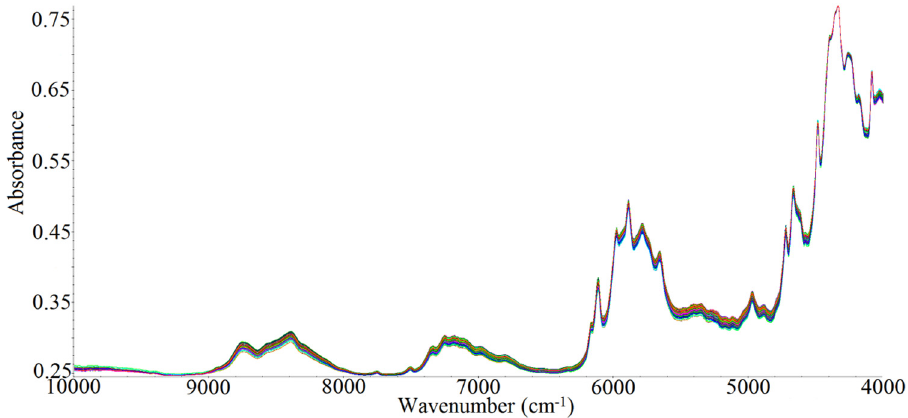
Figure 4: FT - NIR spectra of 210 prepreg